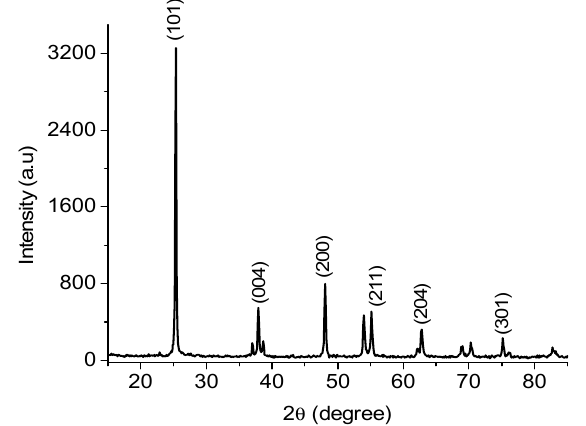
Figure 2. X-ray diffraction (XRD) patterns of the hybrid Au/TiO 2 nanosheets.